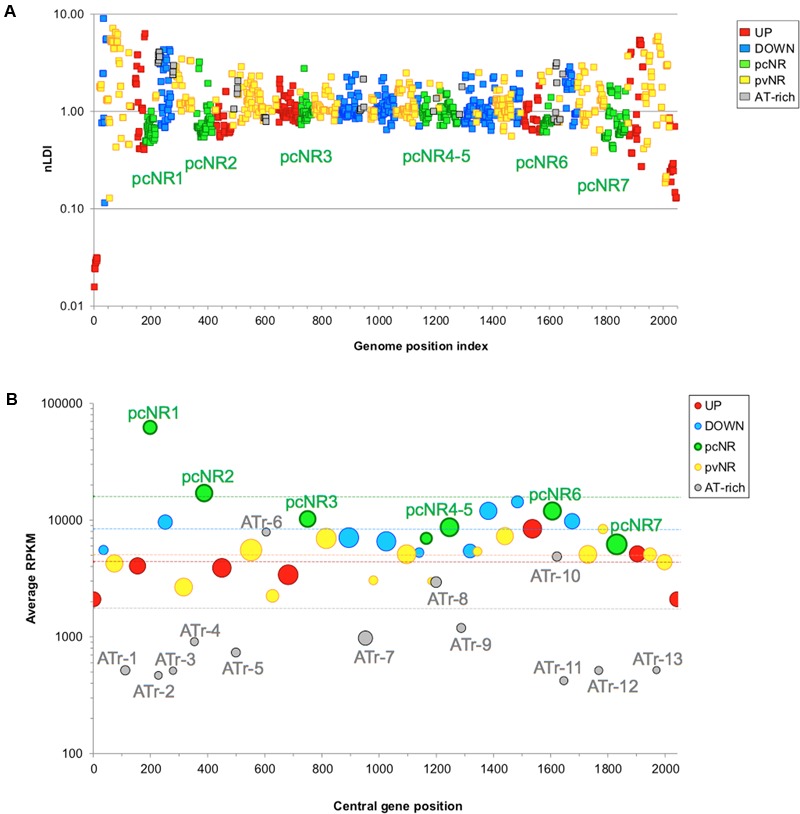
Different domains have different locations and transcription levels. (A) Location of NOV-reactive and pcNR domains. Dots indicate nLDI values for S. pneumoniae R6 genes for the whole Streptococcus genus. A total of 1216 genes coding for proteins in S. pneumoniae R6, with homologs in ≥10 species, were contemplated in the analysis. Gene indexing starts from the replication origin. (B) Abundance of RNA transcripts according to domain type. RNA-Seq data were normalized by gene size (kb) using the reads per kb per million mapped reads (RPKM). The positions of the domains in the genome are represented by the position of the central gene (central gene position, X-axis). The size of the circles is proportional to the number of genes in the domain. Only pvNR clusters with at least 10 members are shown. Horizontal lines in the corresponding color indicate the average RPKM value for each domain class. Taken from Martín-Galiano et al. (2017).